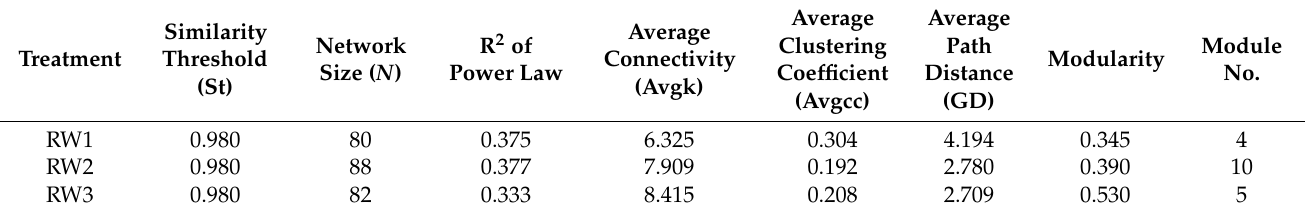
Table 2. Microbial community molecular ecological network topology